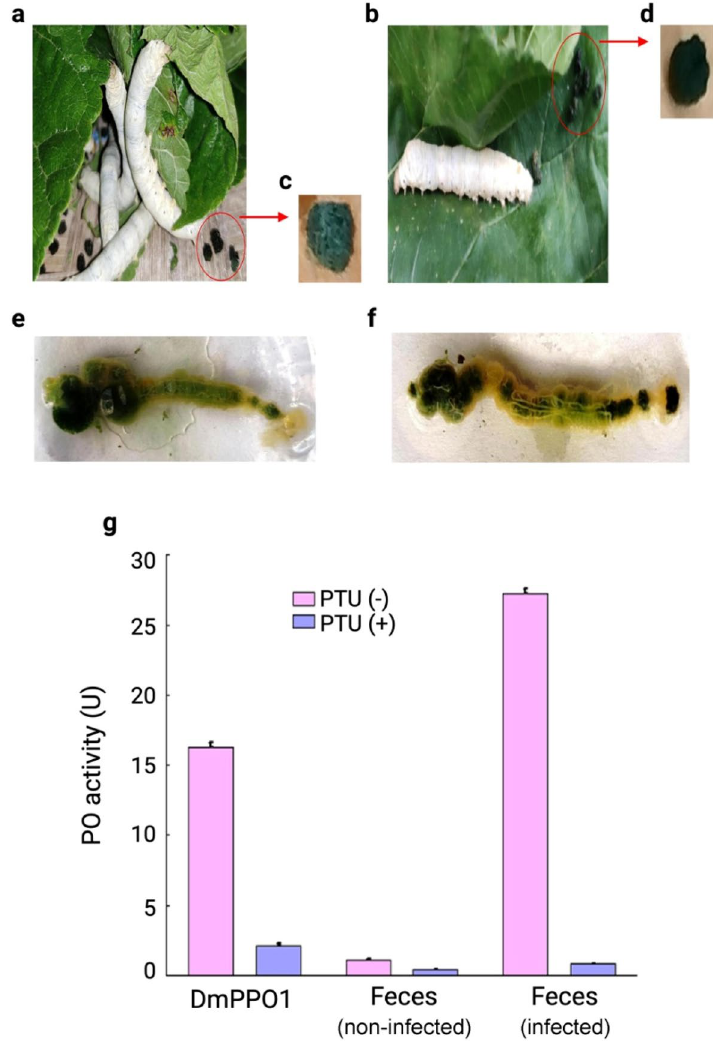
Figure 2. Fecal melanization in non-infected and infected B. mori larvae. ( a ) Non-infected larvae with continued feeding, ( b ) infected larvae that stoppted eating, ( c ) green-colored feces of non-infected larvae, ( d ) black-colored feces of infected larvae, ( e ) dissection showed green gut content in the non-infected larval group, ( f ) black gut content in the infected larval group, and ( g ) polyphenol oxidase (PPO) activity of non-infected and infected silkworm feces. The data were expressed as mean ± standard deviation and the significance level was set at p <